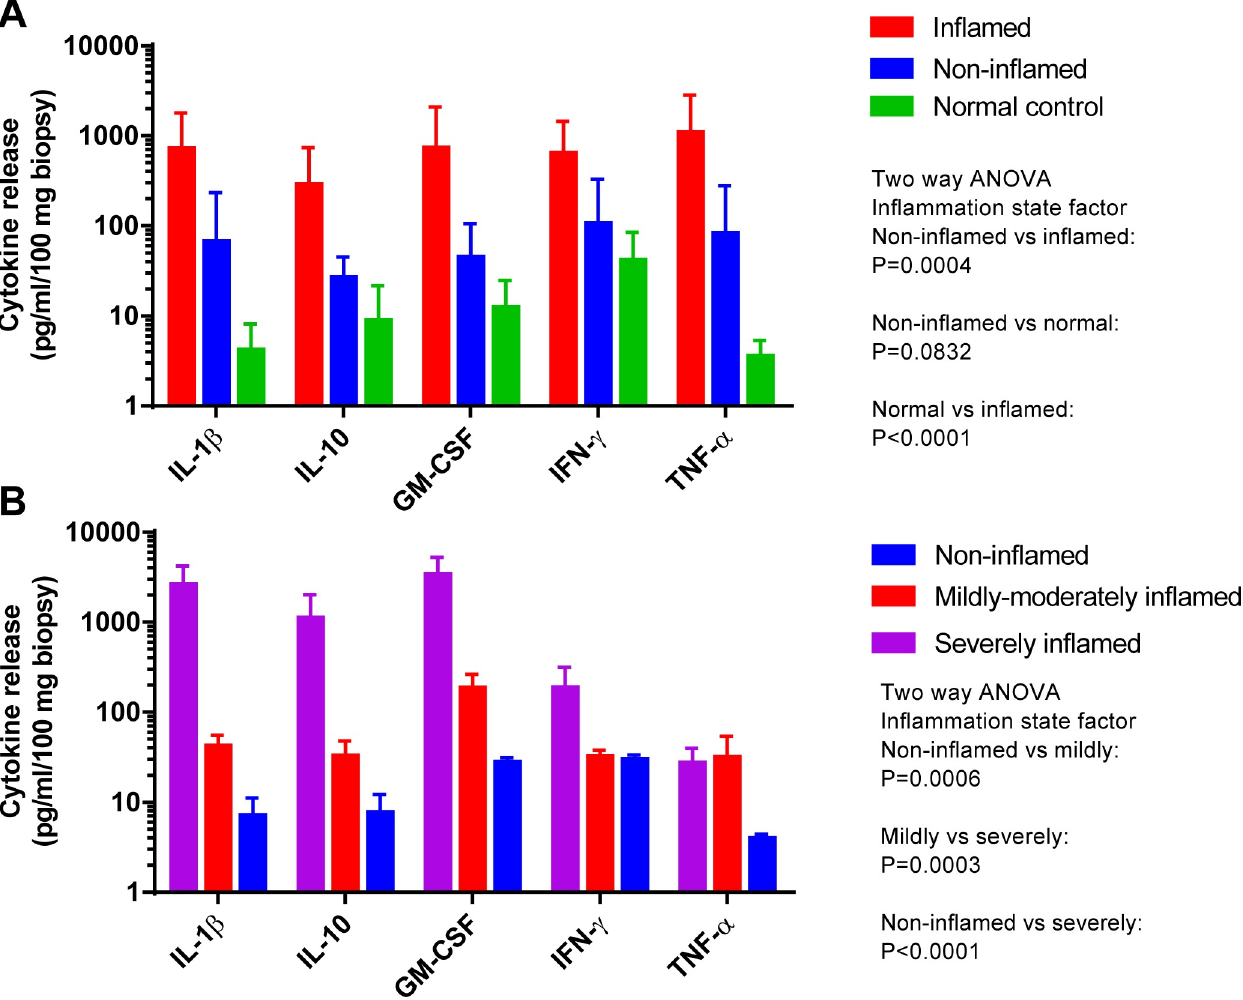
Fig 3. Cytokine release in conditioned medium relative to degree of inflammation as determined by endoscopy and histomorphology. Spontaneous release of the cytokines IL-1 β , IL-10, GM-CSF, IFN- γ and TNF- α from (A) inflamed biopsies (n = 12 patients (2 biopsies/patient)), non-inflamed (n = 10 (2)) and normal controls (n = 6 (4)) into the culture medium measured by Bio-Plex. The inflammation states of CD biopsies were determined by the endoscopist. (B) Spontaneous release from severely inflamed (n = 3 biopsies), mildly/moderately inflamed (n = 6) and non-inflamed (n = 9) CD biopsies from 4 patients as determined by histology. Cytokine levels (pg/ml/100 mg tissue) are expressed as mean ± SEM. Statistical analyses (two-way ANOVA) were performed on the levels of the 5 cytokines in